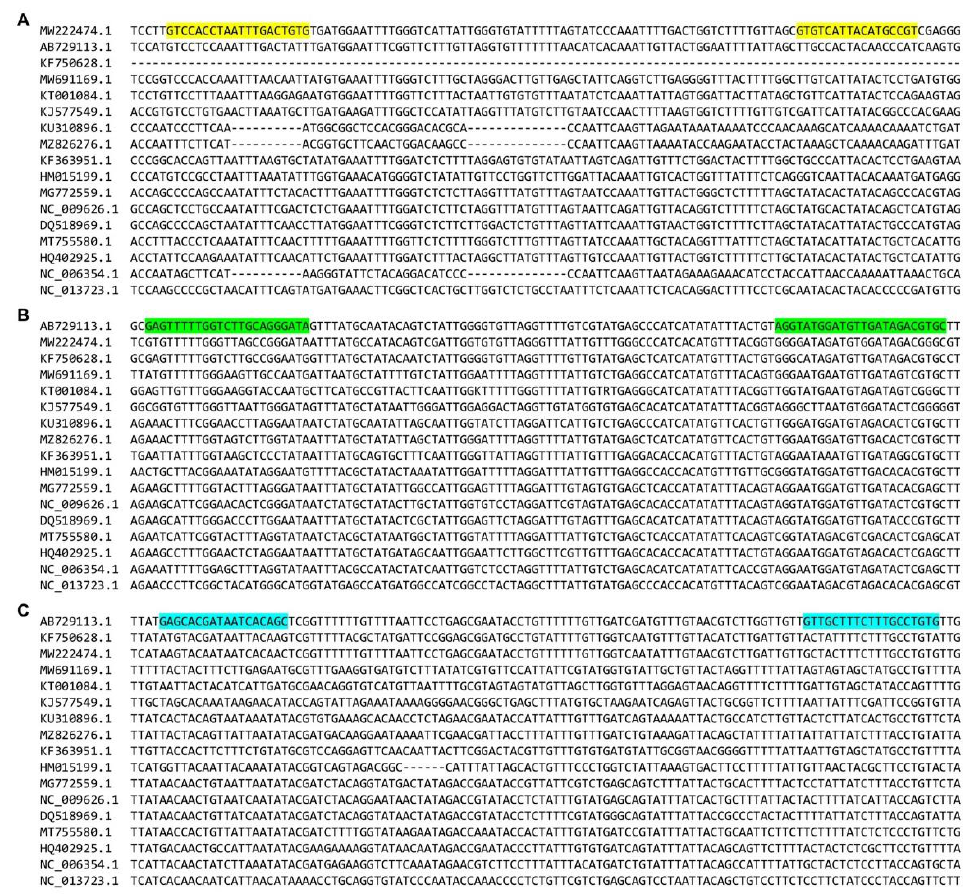
Figure 1. Sequence alignment of the mitochondrial genomes. ( A ) Alignment of cytochrome b (cytb) region against 17 different shellfishes or seafood species and T . granosa -specific primer site (yellow sequences). ( B ) Alignment of cytochrome oxidase subunit I (COI) region against 17 different shellfishes or seafood species and A . broughtonii -specific primer site (green sequences). ( C ) Alignment of COI region against 17 different shellfishes or seafood species and A . kagoshimensis -specific primer region (blue sequences).